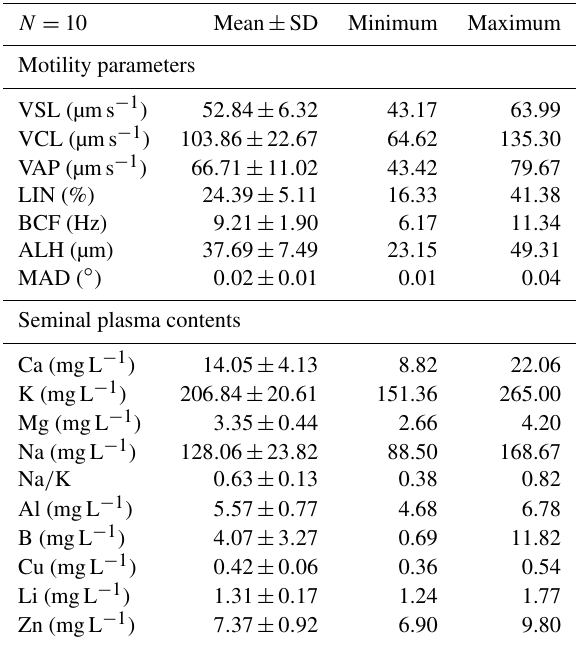
Table 1. The motility parameters of sperm cells and semen seminal plasma contents in Capoeta trutta